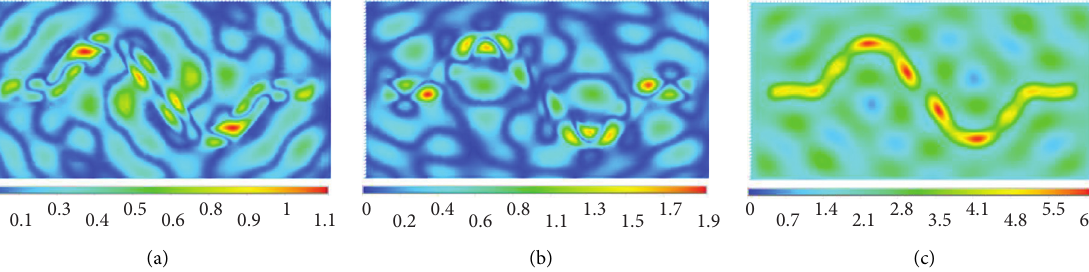
Figure 30: P wave incident ( H � 175m, f � 2.0Hz, C